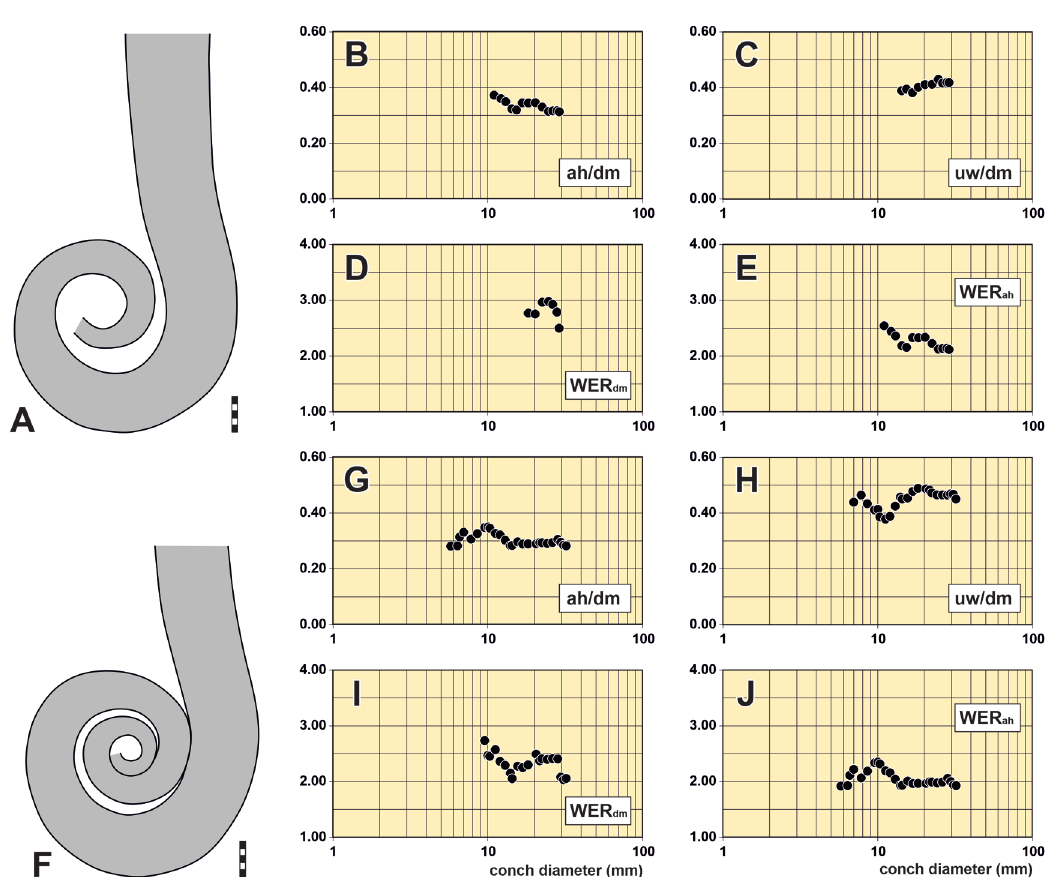
Fig. 40. Lituites perfectus Wahlenberg, 1818. A . Outline of coiled conch part of specimen MB.C.30543. B–E . Conch proportions and coiling rates of specimen MB.C.30543. F . Outline of coiled conch part of specimen MB.C.30545. G–J . Conch proportions and coiling rates of specimen MB.C.30545. Scale bar units = 1